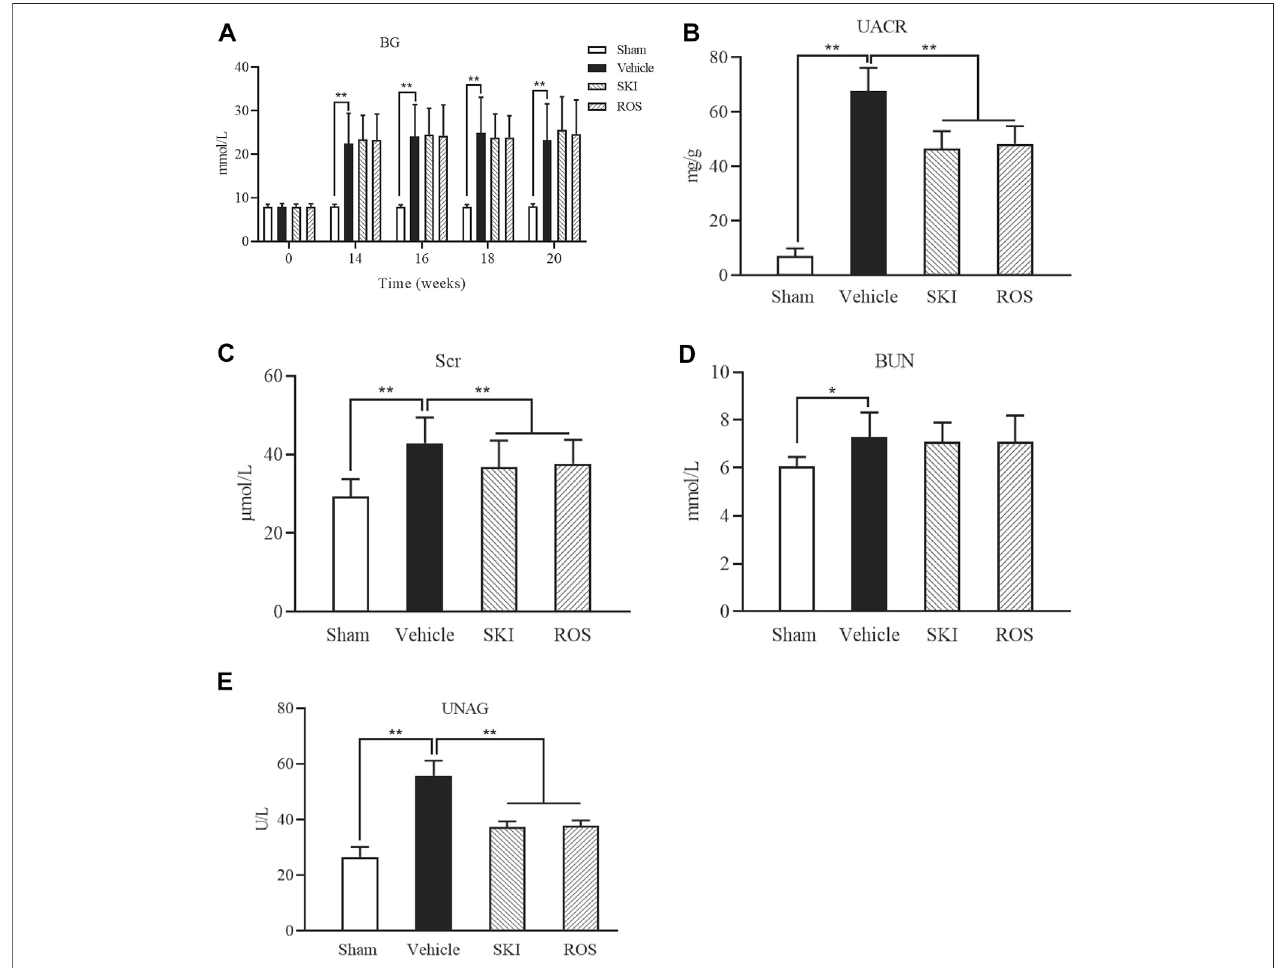
FIGURE 2 | The effects of SKI and ROS on BG (A) , UACR (B) , Scr (C) , BUN (D) , and UNAG (E) in vivo . Data are expressed as mean ± S.E. ** p < 0.01. Abbreviations: BG, blood glucose; UACR, urinary microalbumin to creatinine; Scr, serum creatinine; BUN, blood urea nitrogen; UNAG, urinary N -acetyl-beta- D - glucosaminidase; ROS, rosiglitazone; SKI, Shenkang injection.